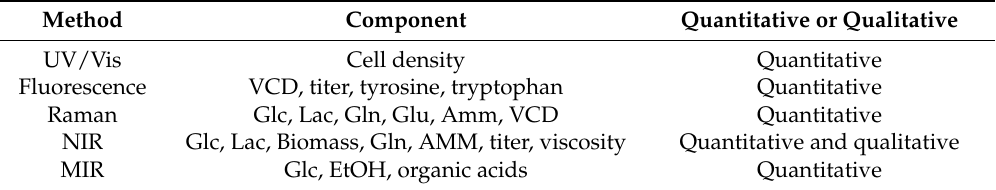
Table 1. Exemplary overview of methods that are able to measure process variables of mammalian cell culture quantitatively or qualitatively, according to [4,13]. UV/Vis, ultraviolet and visible spectroscopy; NIR, near-infrared spectroscopy; MIR mid-infrared spectroscopy; VCD, viable cell